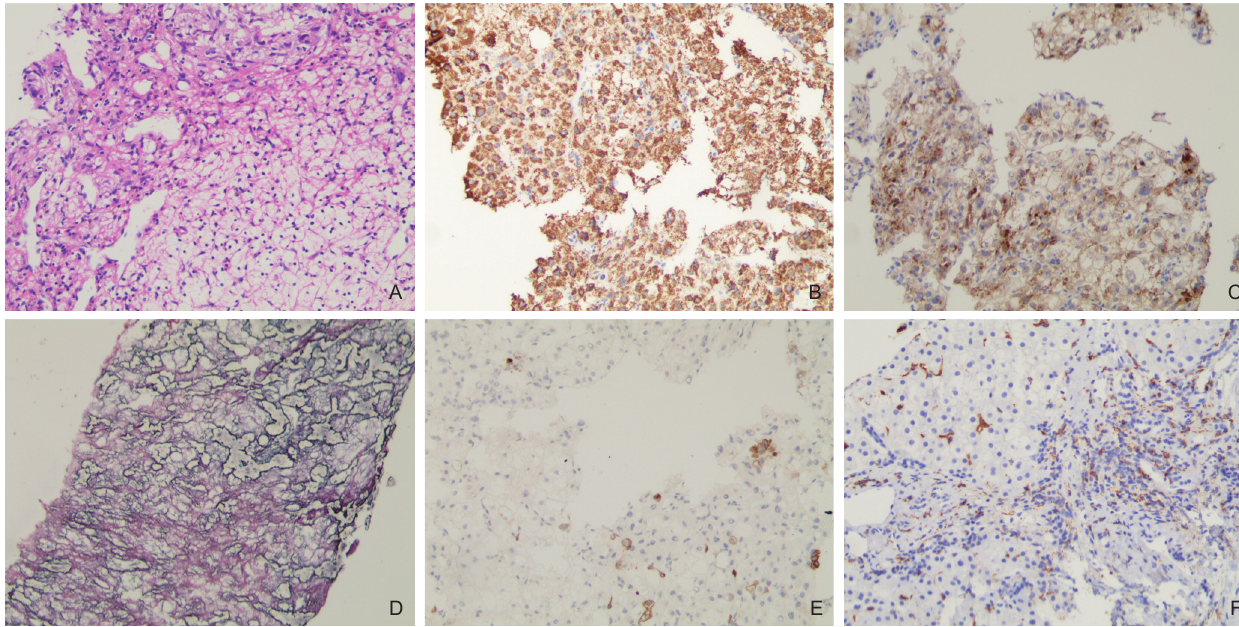
D E Figure 3 The biopsy pathologic image of the lesion, hematoxylin-eosin stain (A). (B-F) Immunohistochemical images of the lesion: Hepatocellular (+), GPC-3 (+), Reticular fiber staining (-), CK7 (-) and CD68 (-) from B to F, respectively.